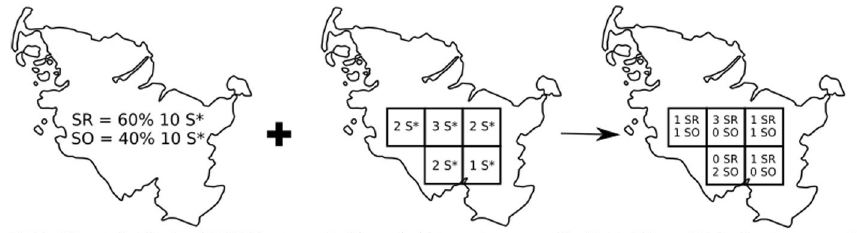
Fig. 2 Exemplary refinement of households in cluster 1 from Singles—S* to SO and SR in (e5–e6) (cf. Table